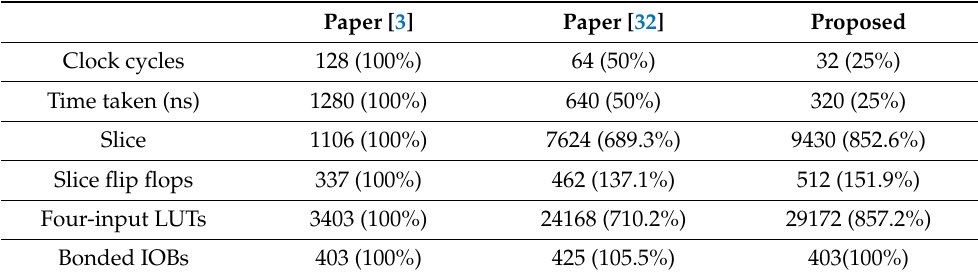
Table 4. Timing waveform and device utilization comparison. Paper